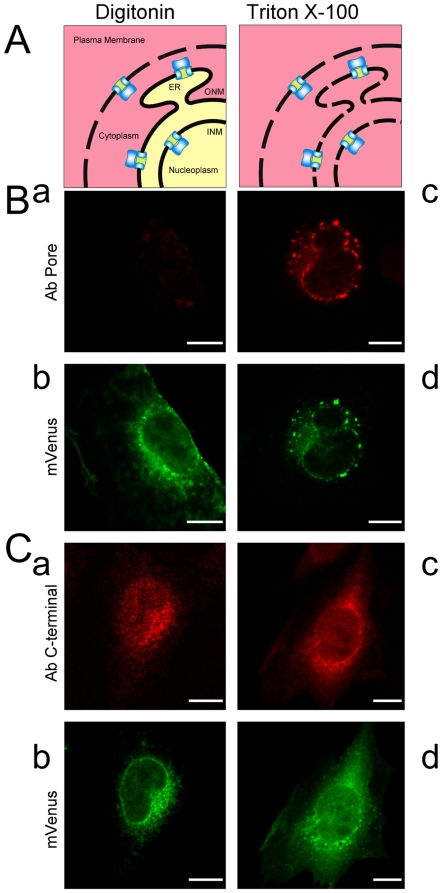
Immunofluorescence microscopy of the intracellular localization of KV10.1-mVenus.A. Schematic representation of the topology of KV10.1 on different (intra)cellular membranes. Two relevant domains of KV10.1 are show: the pore and intracellular C-terminus. Cells in different permeabilized states are shown with red or yellow color representing compartments that are accessible or inaccessible by antibody-containing solution, respectively. In digitonin-permeabilized cells, only the C terminal of ER/ONM KV10.1 is accessible while antibodies can reach neither the pore of ER/ONM KV10.1 nor any domain of the INM KV10.1. In Triton-permeabilized cells, all intracellular KV10.1 is accessible by antibodies. Transiently transfected CHO cells were permeabilized at 4°C by either digitonin (Ba,b; Ca,b) or Triton X-100 (Bc,d; Cc,d), then fixed and labeled with anti-KV10.1 antibody against either the pore (B) or the C-terminal (C). The corresponding fluorescence from the mVenus tagged channel in both treatments is shown in panels b and d. Gaussian blur (d = 2 pixel) was applied to all the images. Scale bar: 10 µm.